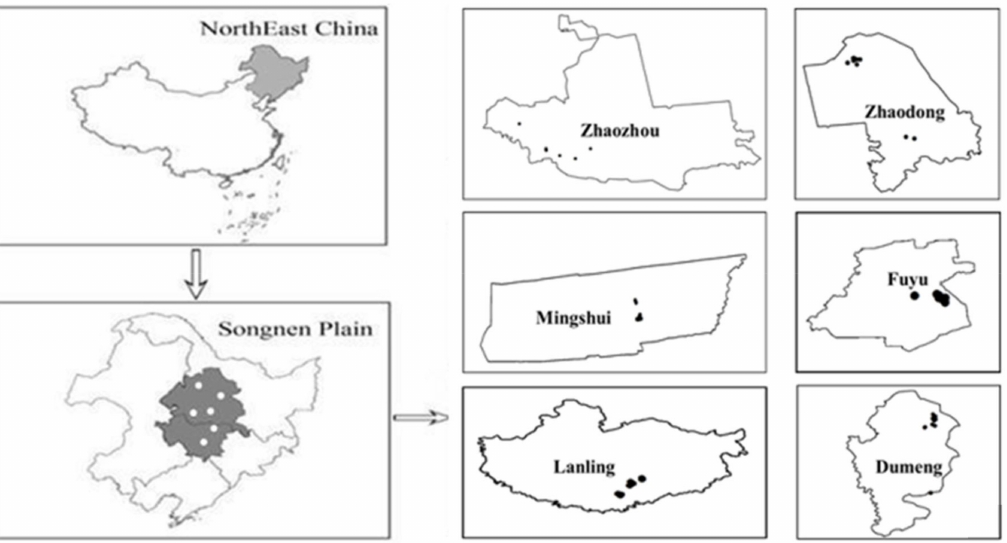
Figure 1. Six study sites in Songnen Plain, Northeastern China. Left: the relative location of the study sites in China and in Songnen Plain. Right: the relative location of the sites in six regions (Zhaozhou, Zhaodong, Mingshui, Fuyu, Lanling and